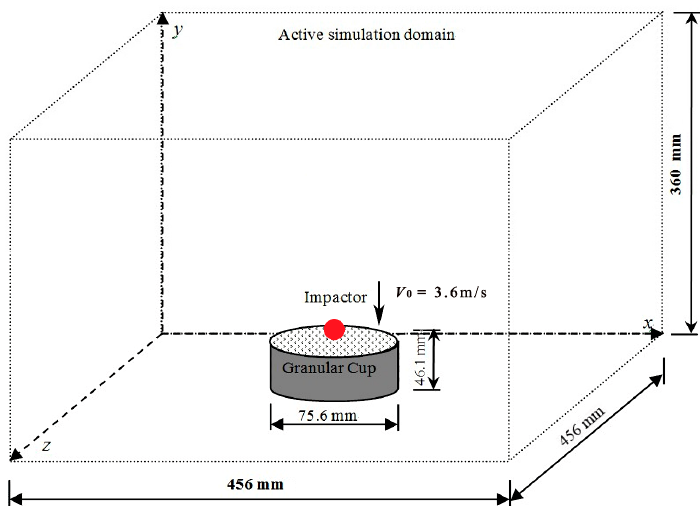
Figure 2. Schematic diagram of numerical setup. (The arrow represents the velocity direction of the impactor.)